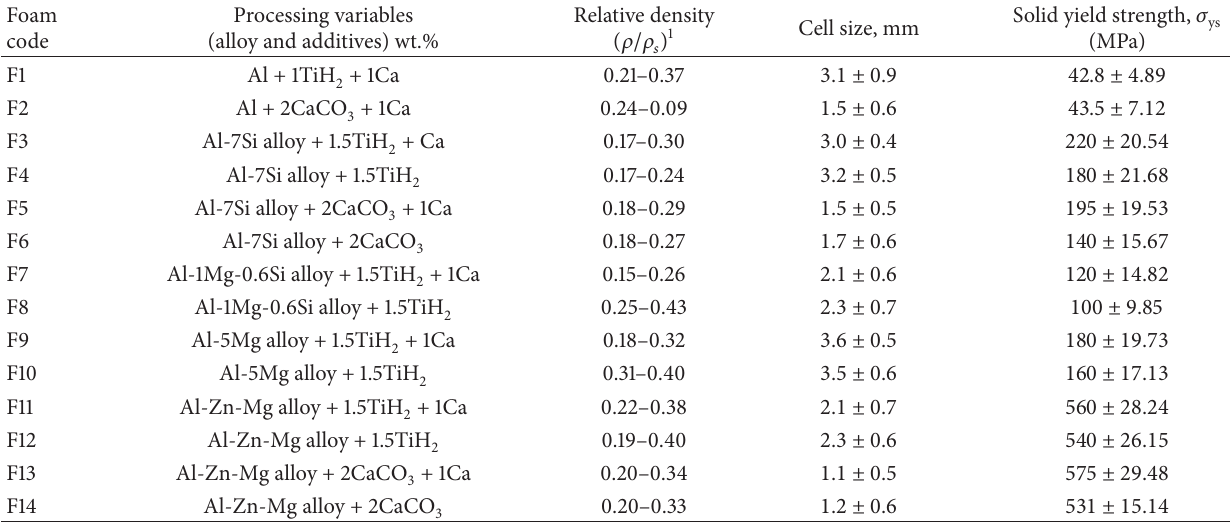
Table 1: Characteristics for different kinds of Al-based foams produced by Alporas like